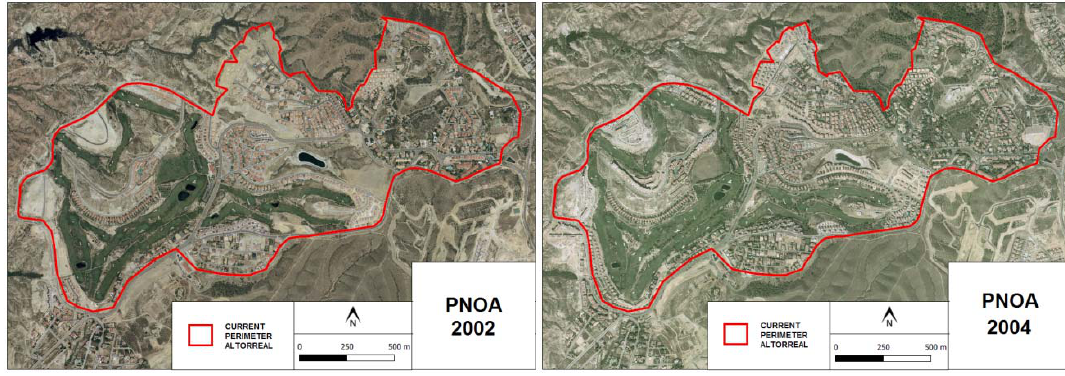
Figure 6. Evolution of the urban fabric in Altorreal at the beginning of the 21st century.